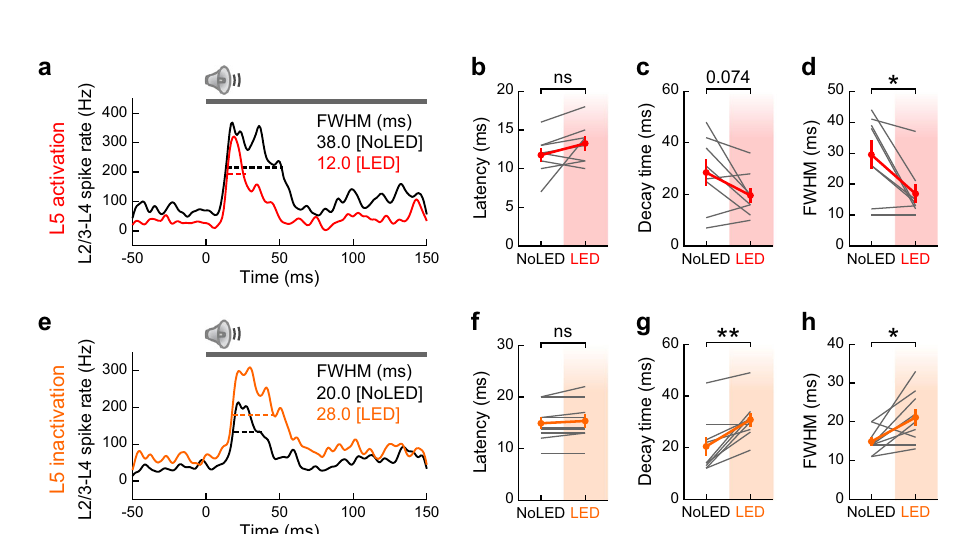
Fig. 3 Optogenetic activation of L5 sharpens the spectral tuning in super fi cial layers. a – h Data for A1 tone-evoked responses during L5 activation with ChrimsonR. a Tone evoked responses of a representative L2/3 RS single-unit with (red) and without (black) L5 activation. Left and middle, raster plots of tone-evoked spikes for nine tone frequencies. LED and No LED trials were interleaved but are separated for clarity. Red bar, 625 nm illumination. Gray shading, tone. Right, PSTH. b Isointensity function for the unit shown in a . Data are mean ± SEM of nine trials. c Scatter plots showing MI for the tone- evoked fi ring of RS single-units in each layer across mice (11 mice; n = 28, 24, 43 tone-responsive units and 51, 46, 131 responsive unit-frequency pairs for L2/3, L4, L6). Red dots and bars represent median and 25th and 75th percentiles, respectively. * p < 0.05, ** p < 0.01, *** p < 0.001. Individual groups: two- sided Wilcoxon signed rank test with Bonferroni correction (black asterisks). Comparisons across groups: two-sided Wilcoxon rank sum test with Bonferroni correction (brown asterisks). d Violin plots showing LED-induced changes in the population frequency tuning bandwidth at 70 dB SPL (BW 70 ) in each layer. Thick lines indicate mean. Two-sided Wilcoxon signed rank test with Bonferroni correction. e Tone-evoked spike counts of representative L2/3 RS single-units with divisive (left; unit shown in a ) or both divisive and subtractive (right) suppression with LED. Blue lines show fi t with threshold-linear functions. Dotted lines indicate x = 0, y = 0, and unity. f Summary data showing well- fi t RS single-units in L2/3 – L4 (n = 33 single-units, 297 unit-tone pairs). Spike counts are normalized to the BF response without LED in each unit. Blue line and shading show mean and SEM of all linear fi t lines of suppressed units. Suppressed units (blue circles) were de fi ned by the MI of the total spike counts for all responsive frequencies; therefore, some of the data points for suppressed units could appear above the unity line. g Distribution of best- fi t slope (top left) and normalized y-intercept (bottom left) for all L2/3 – L4 RS single-units that were fi t well with threshold-linear functions. Blue bars indicate units with signi fi cant suppression of tone-evoked activity. Arrows show median. Right, a pie chart showing the fraction of units with divisive (brown), subtractive (green), both suppression (black), other modulations (white), and no change (gray) ( n = 33 units excluding units with poor fi tting). h – n Same as in a – g but for L5 inactivation with eNpHR3. i Data are mean ± SEM of nine trials. j 14 mice; n = 28, 30, 53 tone-responsive units and 95, 91, 177 unit-frequency pairs for L2/3, L4, L6. l Tone-evoked spike counts of representative L2/3 RS single-units with additive (left; unit shown in h ) or multiplicative (right) enhancement with LED. Pink lines show fi t with threshold-linear functions. m n = 44 single-units, 396 unit-tone pairs. Pink line and shading show mean and SEM of all linear fi t lines of enhanced units. n n = 44 units that were fi t well with threshold-linear functions. See Supplementary Data 1 for additional statistics. Source data are provided as a Source Data fi le.